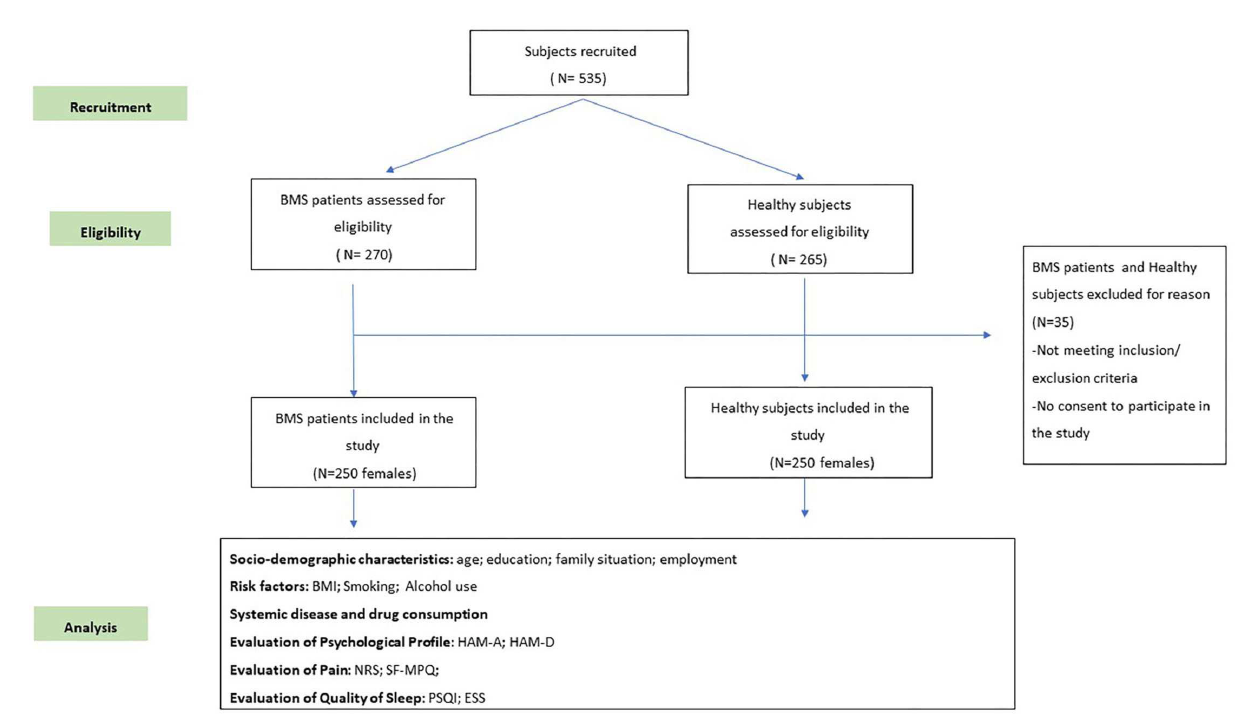
FIGURE1 A flow chart of the study. BMS, burning mouth syndrome; BMI, Body Mass Index; ESS, Epworth Sleepiness Scale; HAM-A, Hamilton Rating Scale for Anxiety; HAM-D, Hamilton Rating Scale for Depression; NRS, Numeric Rating Scale; PSQI, Pittsburgh Sleep Quality Index; SF-MPQ, Short-Form McGill Pain